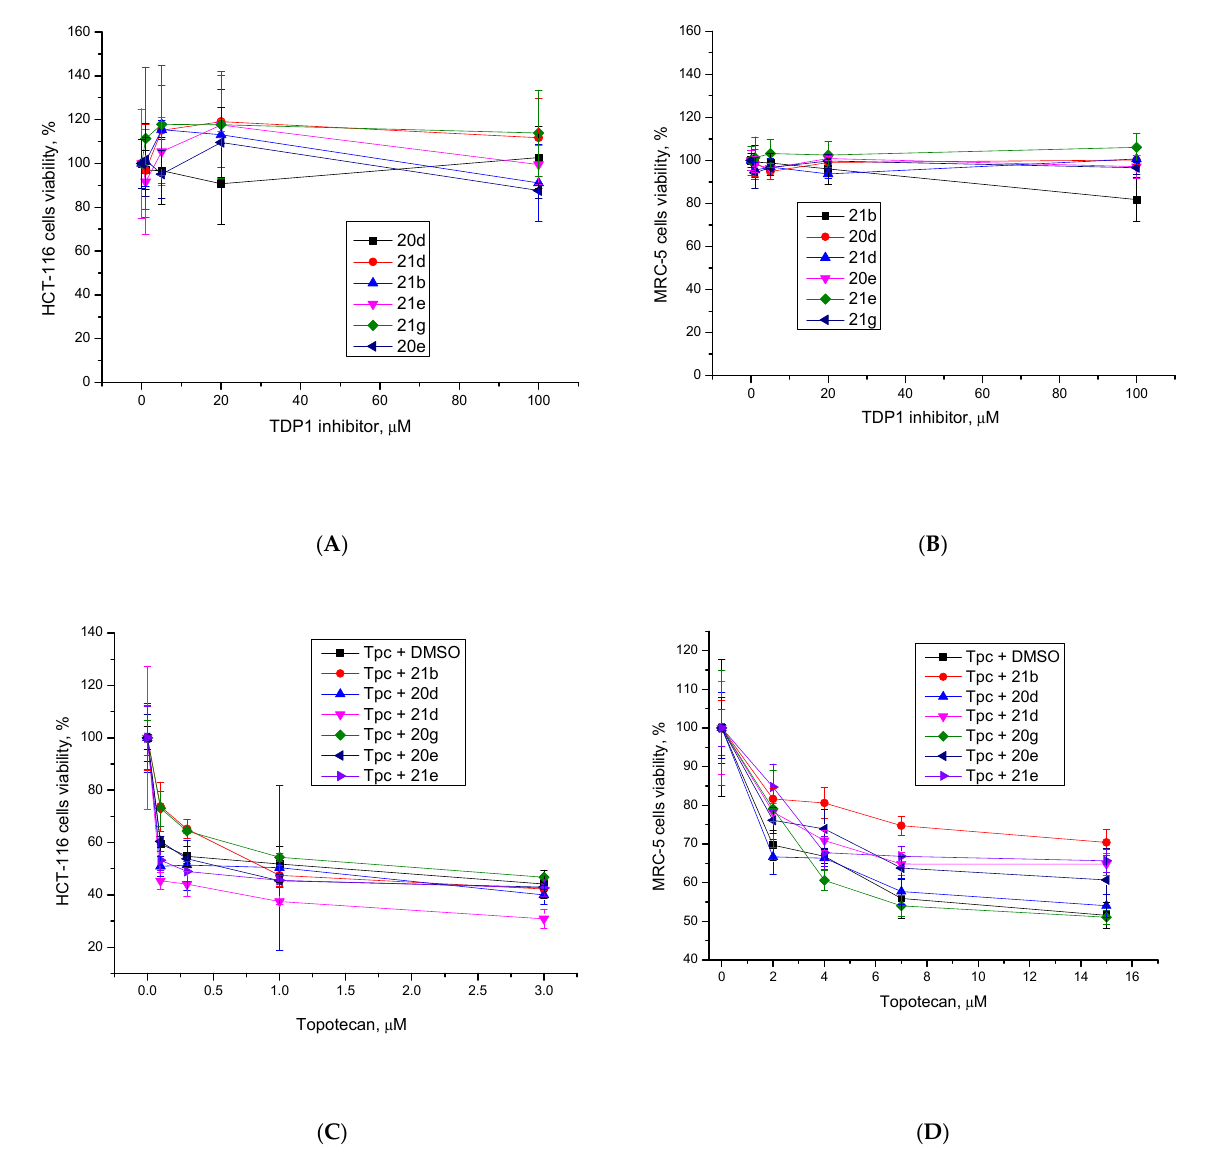
Figure 2. Influence of compounds on the cell line viability. The TDP1 inhibitors’ intrinsic cytotoxicity on HCT-116 cells ( A ) and MRC-5 cells ( B )—dose-dependent action. Topotecan (Tpc) cytotoxicity in the presence of TDP1 inhibitors in HCT-116 ( C ) and MRC-5 ( D ) cells. According the EZ4U test data the thiazolidine-2,4-diones were shown not to enhance the cytotoxic effect of topotecan at 10 µ M (Figure 2C,D). In some cases, the